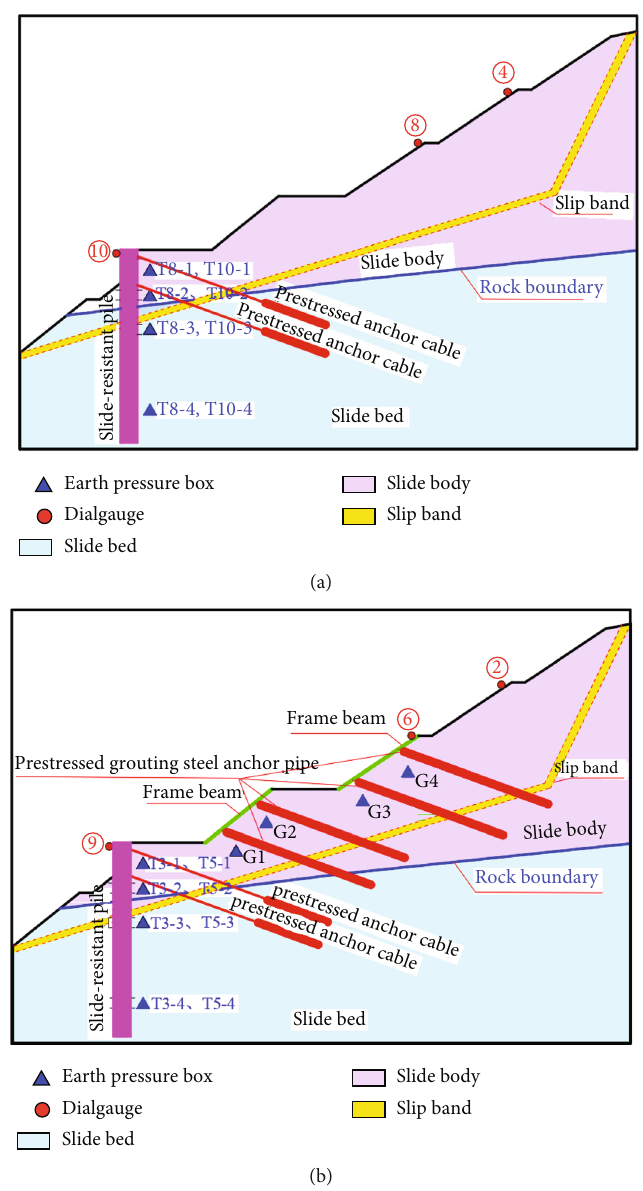
Figure 3: Layout of measuring instruments. (a) The side of setting the prestressed grouting steel anchor tube frame beam. (b) The side of without the prestressed grouting steel anchor tube frame